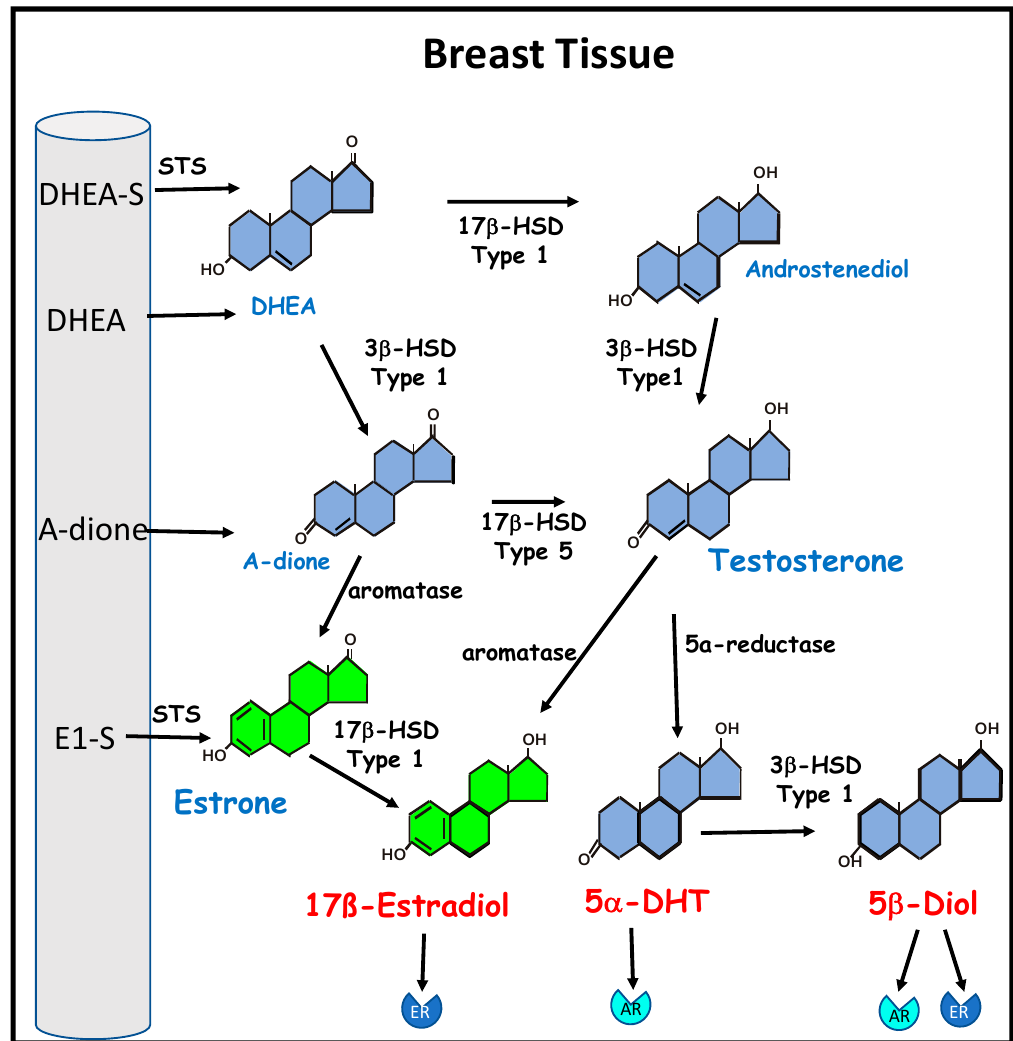
Figure 2. The biosynthesis of estrogen from inactive circulating precursors in breast cancer. Bioactive estrogen can be synthesized by breast cancer cells and breast stromal tissue from circulating precursor steroids. These include the adrenal androgens dehydroepiandrosterone (DHEA) and androstenedione (A ‐ dione); dehydroepiandrosterone sulphate (DHEA ‐ S), the major circulating androgen, and estrone sulphate (E1 ‐ S), the major circulating estrogen in postmenopausal women, which can be converted to DHEA and estrone (E1), respectively, by steroid sulfatase (STS). DHEA and androstenediol are metabolized by 3 β‐ hydroxysteroid dehydrogenase (3 β‐ HSD) type 1 to the estrogen precursors A ‐ dione and testosterone. Testosterone can be metabolized by 5 α‐ reductase to the potent androgen 5 α‐ dihydrotestosterone (5 α‐ DHT), which has a high affinity for the androgen receptor (AR). Type 1 3 β‐ HSD can convert 5 α‐ DHT to 5 α‐ androstane ‐ 3 β ,17 β‐ diol (5 β‐ diol), which is an agonist of both the AR and the estrogen receptor (ER). Aromatase is required for the conversion of testosterone to 17 β‐ estradiol and conversion of A ‐ dione to E1, which can be further metabolized by 17 β‐ hydroxysteroid dehydrogenase (17 β‐ HSD) type 1 to 17 β‐ estradiol, which has a high affinity for ER.